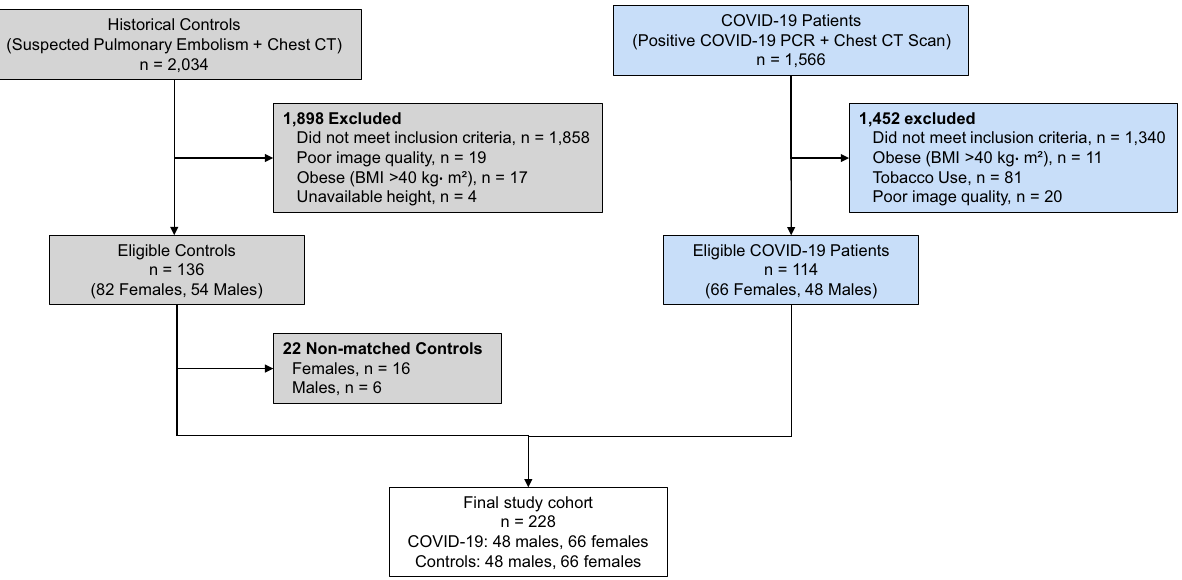
Figure 1. Flow chart of patient eligibility and control matching for the